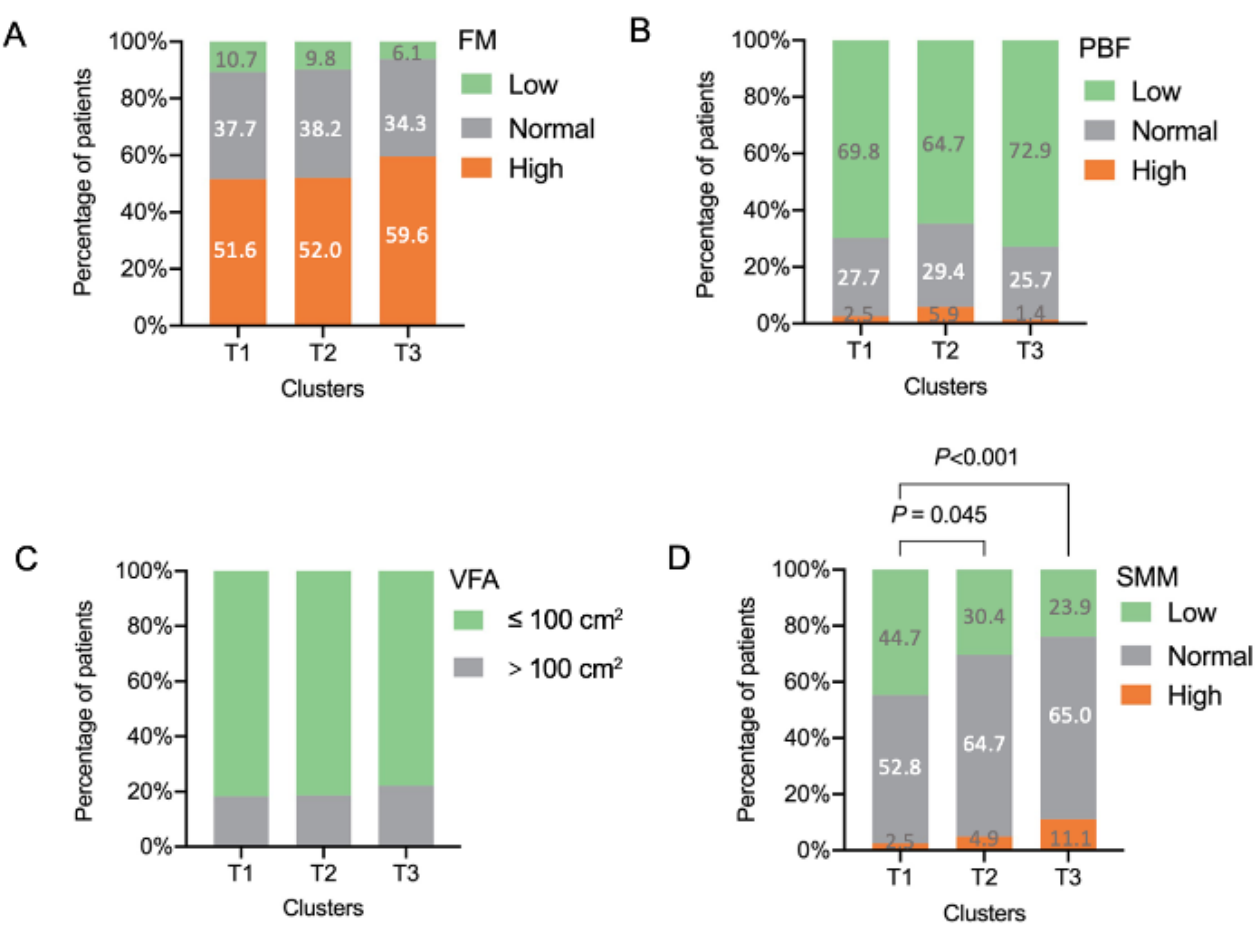
(Table 1), and lower SMM (21.57 (4.07) kg) and proportion of patients in the low level of SMM (44.7%, p < 0.001) (Figure 2) compared with those in cluster T3. Undernutrition is characterized by a reduction of the fat-free mass (FFM, mainly SMM) and fat mass (FM) [43]. Therefore, compared with cluster T2 and T3, cluster T1 was defined as “patients with undernutrition”.